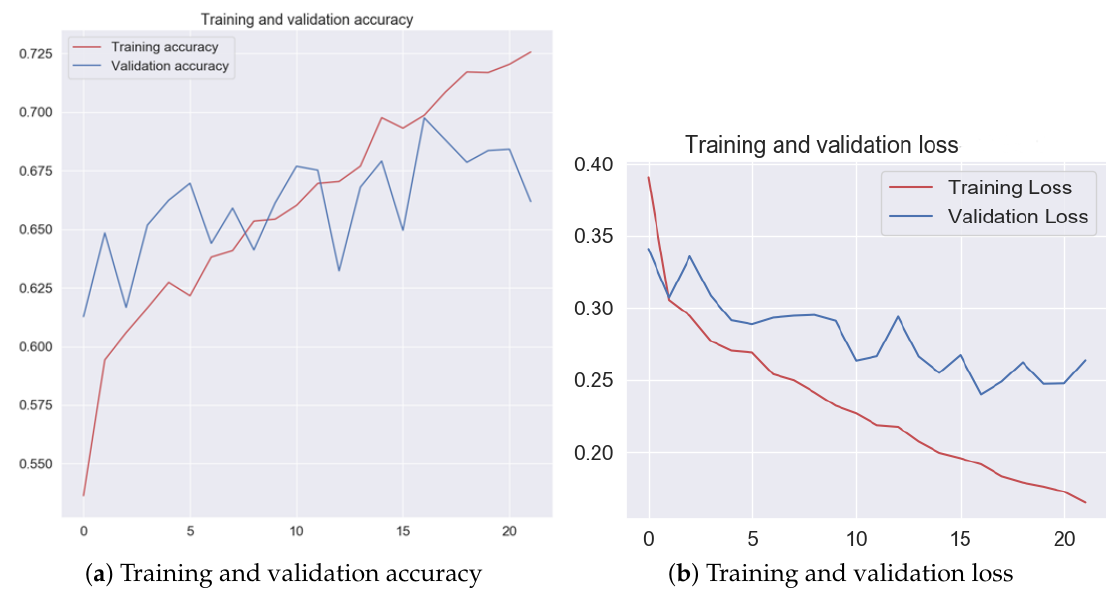
Figure 7. Example function changes for training and validation accuracy ( a ) and loss ( b